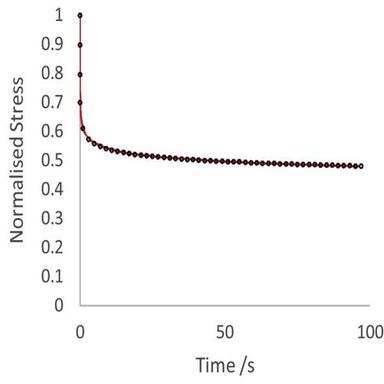
Normalised uniaxial stress relaxation data, with Prony series curve fit.